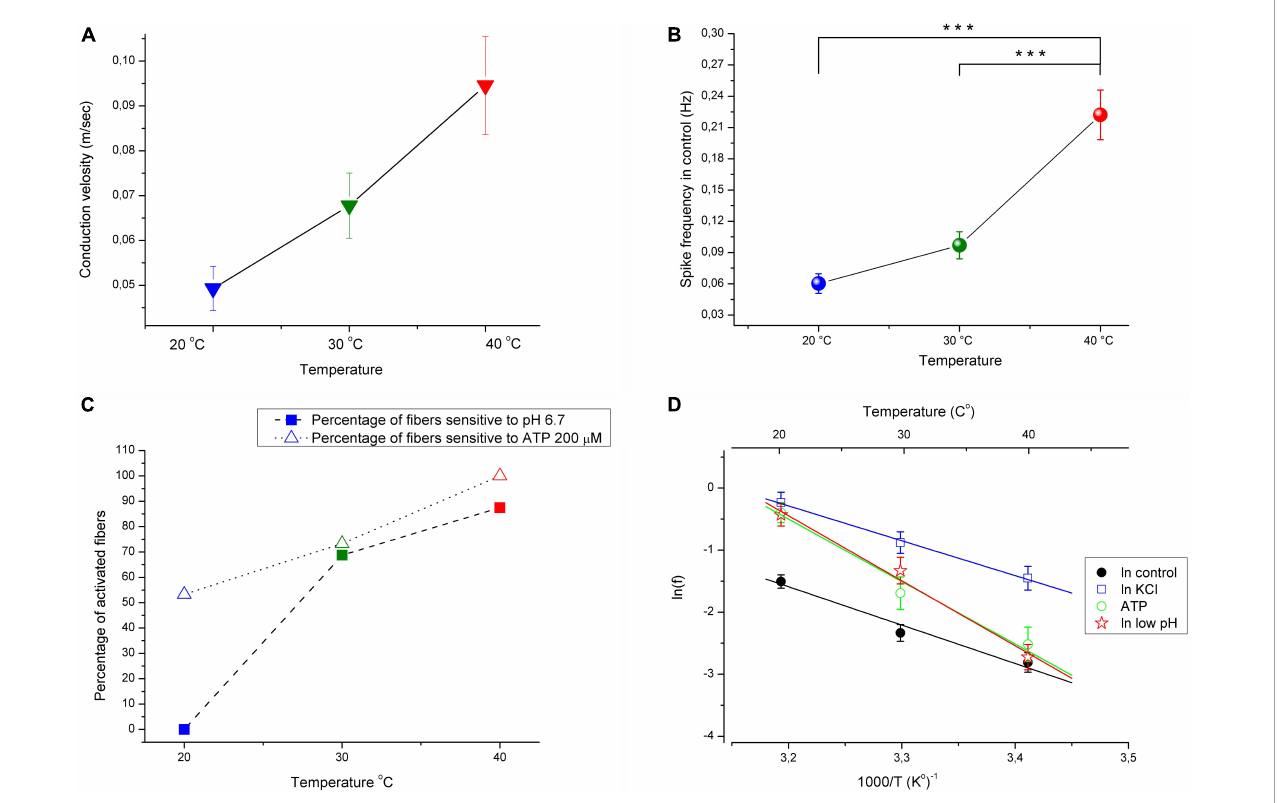
FIGURE1 (A) Conduction velocity is temperature dependent with Q 10 ≈ 1.4. (B) Increasing the temperature under control conditions from 30 to 40 ◦ C resulted in significant increases in the spontaneous activity of afferent nerve fibers ( n = 71; MEAN ± SEM; p < 0.001). (C) The increasing temperature during application of low pH solution (pH 6.7) and ATP 200 µ M results in increasing the number of fibers activated by low pH and ATP. KCl 10.8 mM activated 100% nerve fibers at all investigated temperatures (not showed). (D) Arrhenius plot of the temperature dependence of the spikes frequency of CMH nociceptors in control–black closed circles and line; during acidification–red open stars and line; during application ATP (200 µ M)–green open circles and line; during stimulation fibers with high KCl (10.8 mM)–blue open squares and line. Here, averaged data (MEAN ± SEM) over the entire range of chemical stimulation and control recording were taken into account. The activation energy Ea and Q 10 were determined from linear regression parameters (see section “Materials and methods” for details). *** p <